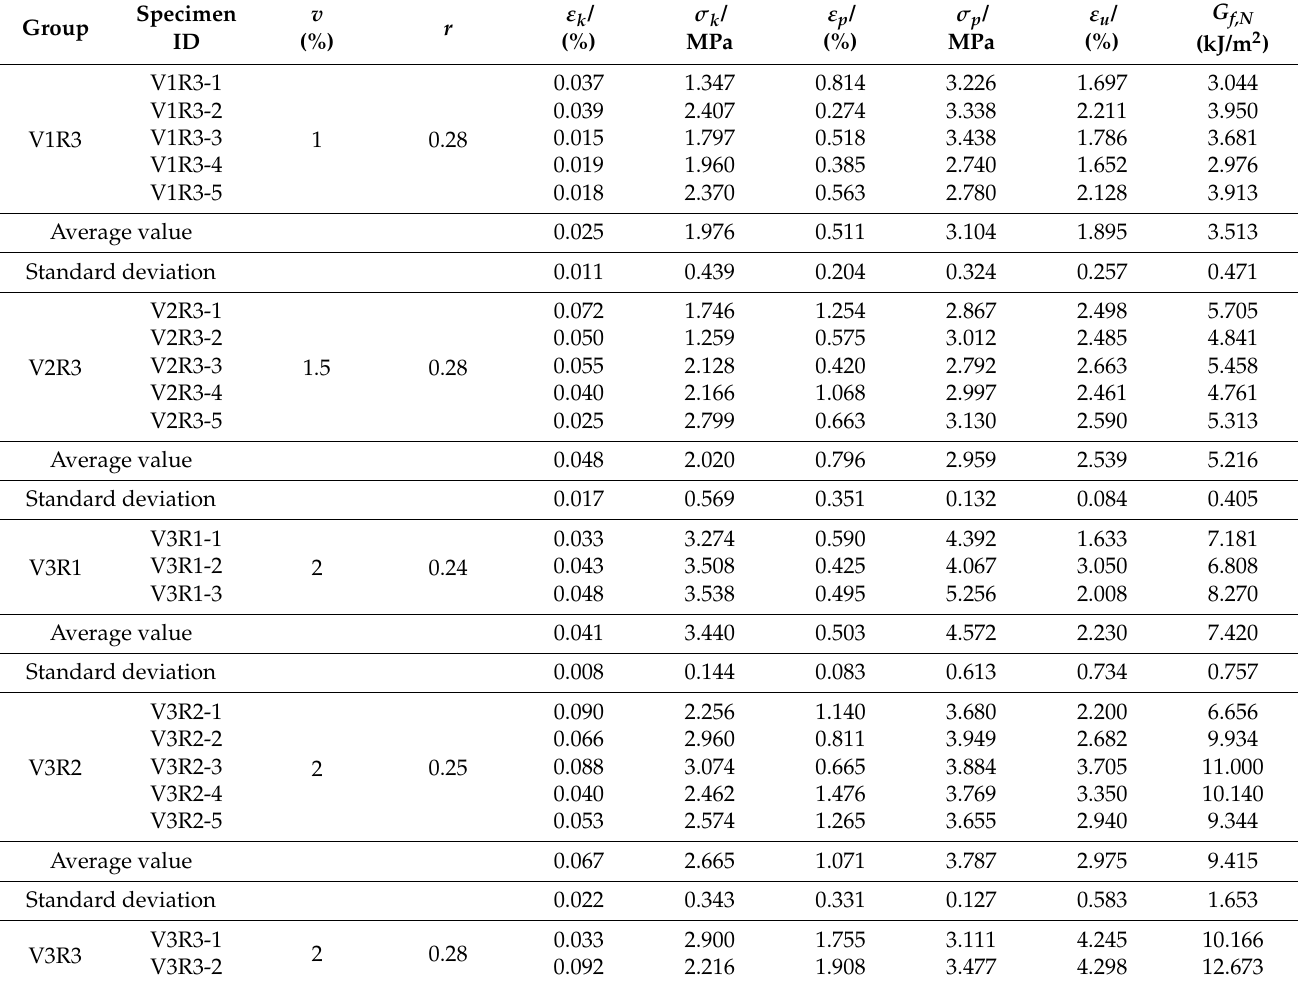
Table 3. Details of specimens and test